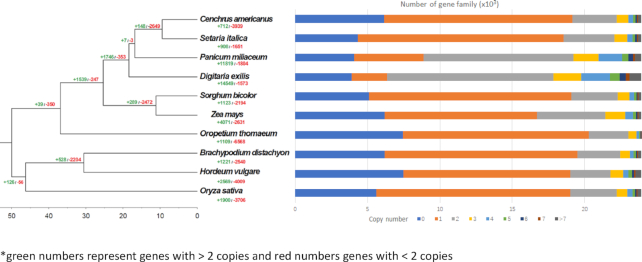
The number of gene families that expanded or contracted during evolution mapped to the species phylogenetic tree in related Poaceae species.